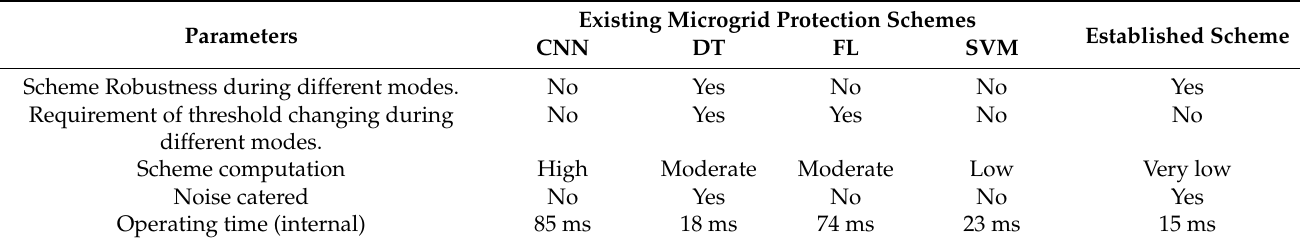
Table 3. Performance analysis with other existing methods.